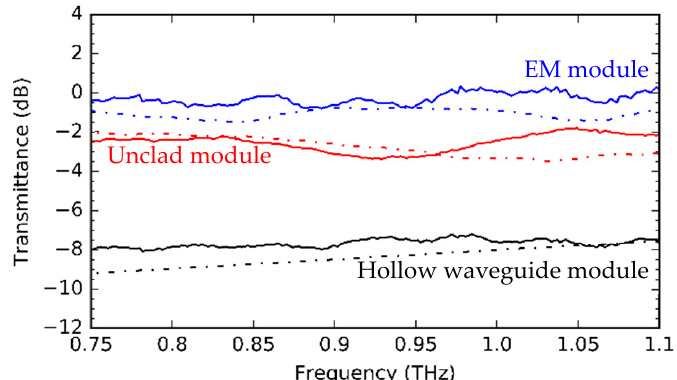
Figure 12. Measured (solid) and simulated (dashed) transmittance of fabricated modules. The modules are 56.2 mm-long. The unclad and EM modules incorporate each 50 mm unclad and 50 mm EM waveguide, respectively.